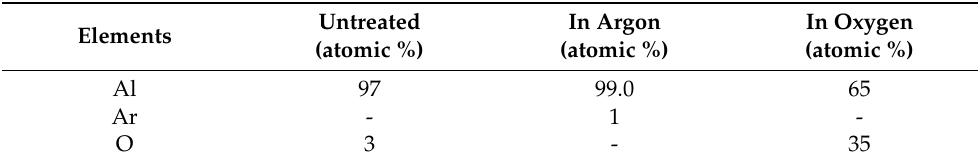
Table 1. An EDS analysis of the un-irradiated and nanosecond laser-irradiated Al targets, at a